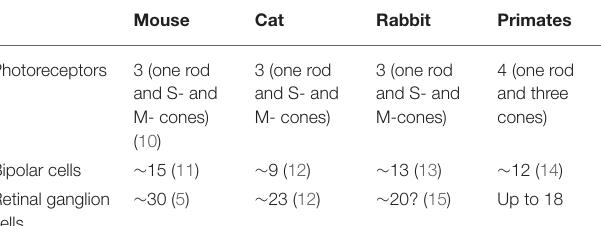
Mouse Cat Rabbit Primates